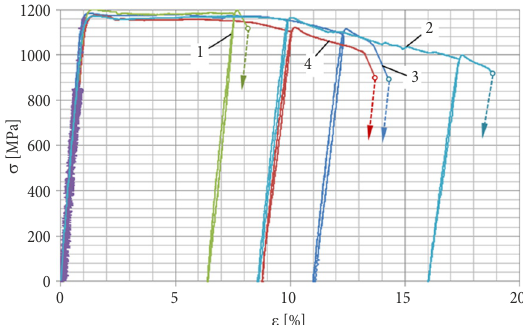
Fig. 8. Stress–strain curves for titanium alloy VT22: 1 – ST; 2 – ST + DNP ( F imp = 60 kN) + ST; 3 – HLN + ST; 4 – DNP ( F imp = 60 kN) before the yield point of the alloy HLN + ST